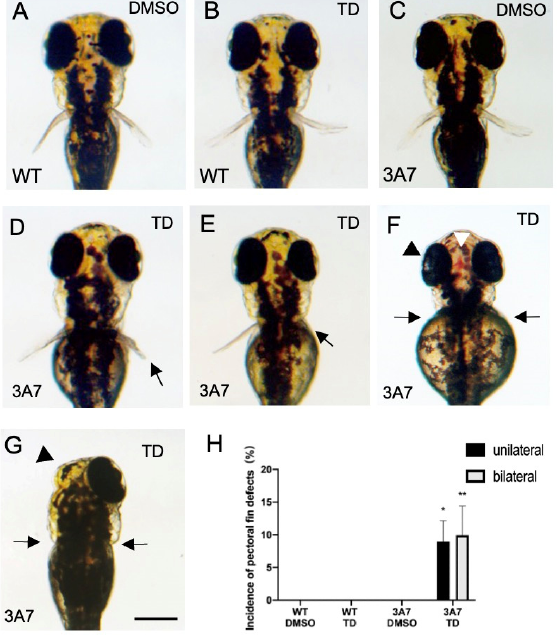
Figure 2. Effects of thalidomide on pectoral fin development of hCYP3A7-expressing zebrafish. Em- bryos/larvae of wild-type (WT) zebrafish ( A , B ) and hCYP3A7-expressing zebrafish (3A7) ( C – G ) were exposed to 200 µM thalidomide (TD) or 0.02% DMSO as a vehicle from 17 hpf to 72 hpf. Arrows in ( D – G ) indicate pectoral fin malformation. The white arrowhead in ( F ) indicates bleeding in the dorsal head region. Black arrowheads show a smaller eye ( F ) and loss of an eye ( G ). Scale bar = 200 µm. A summarized graph is presented in H ( n = 6, 8–26 zebrafish for each case). * p < 0.05, ** p < 0.01.